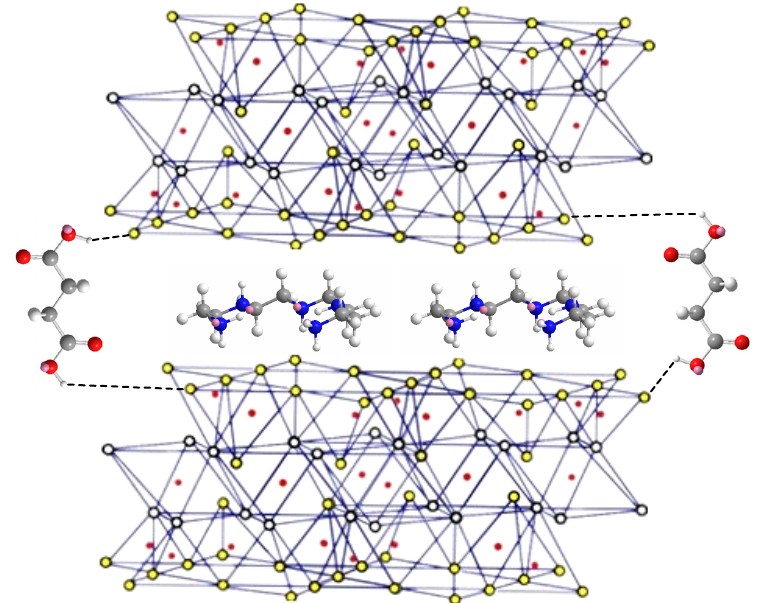
Figure 7. Molecular model for the interaction between organic amine inhibitors and clay.